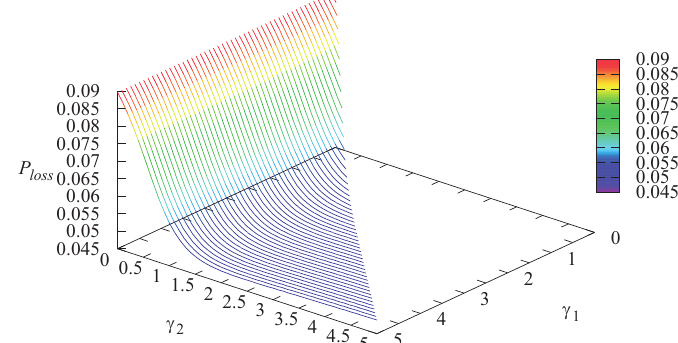
Figure 8. Dependence of the probability P imp − loss that an arbitrary customer will be lost due to impatience from the infinite buffer on γ 1 and γ 2 .